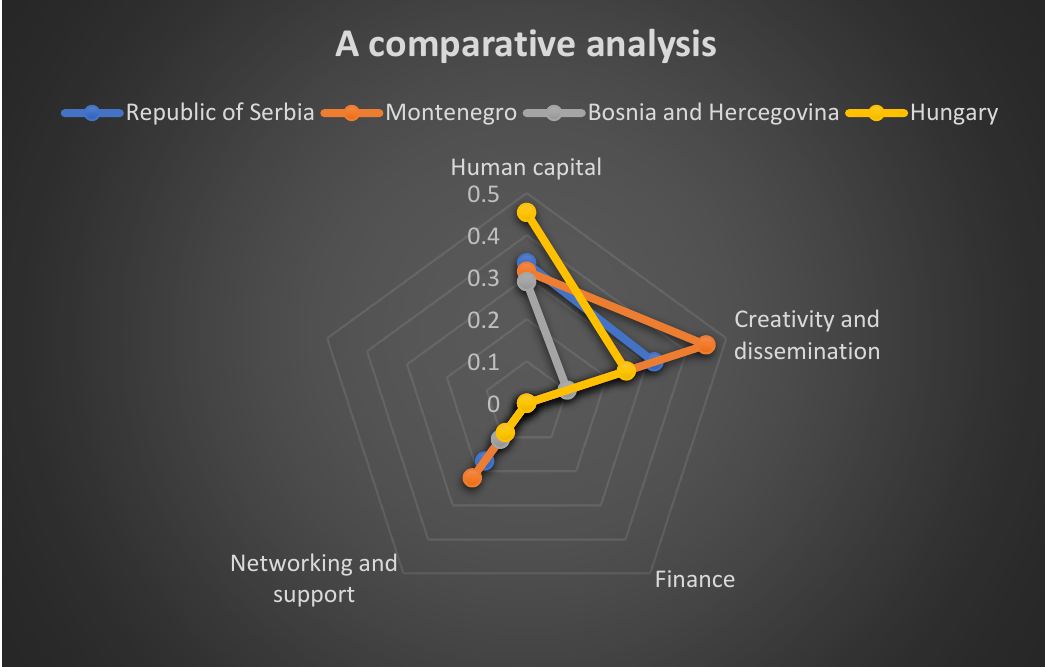
Figure 6. Values of factors that make up the scale-up phase of the life cycle of digital entrepreneurial system enterprises in the digital dimension, for the Republic of Serbia, Montenegro, Bosnia and Herzegovina and Hungary.